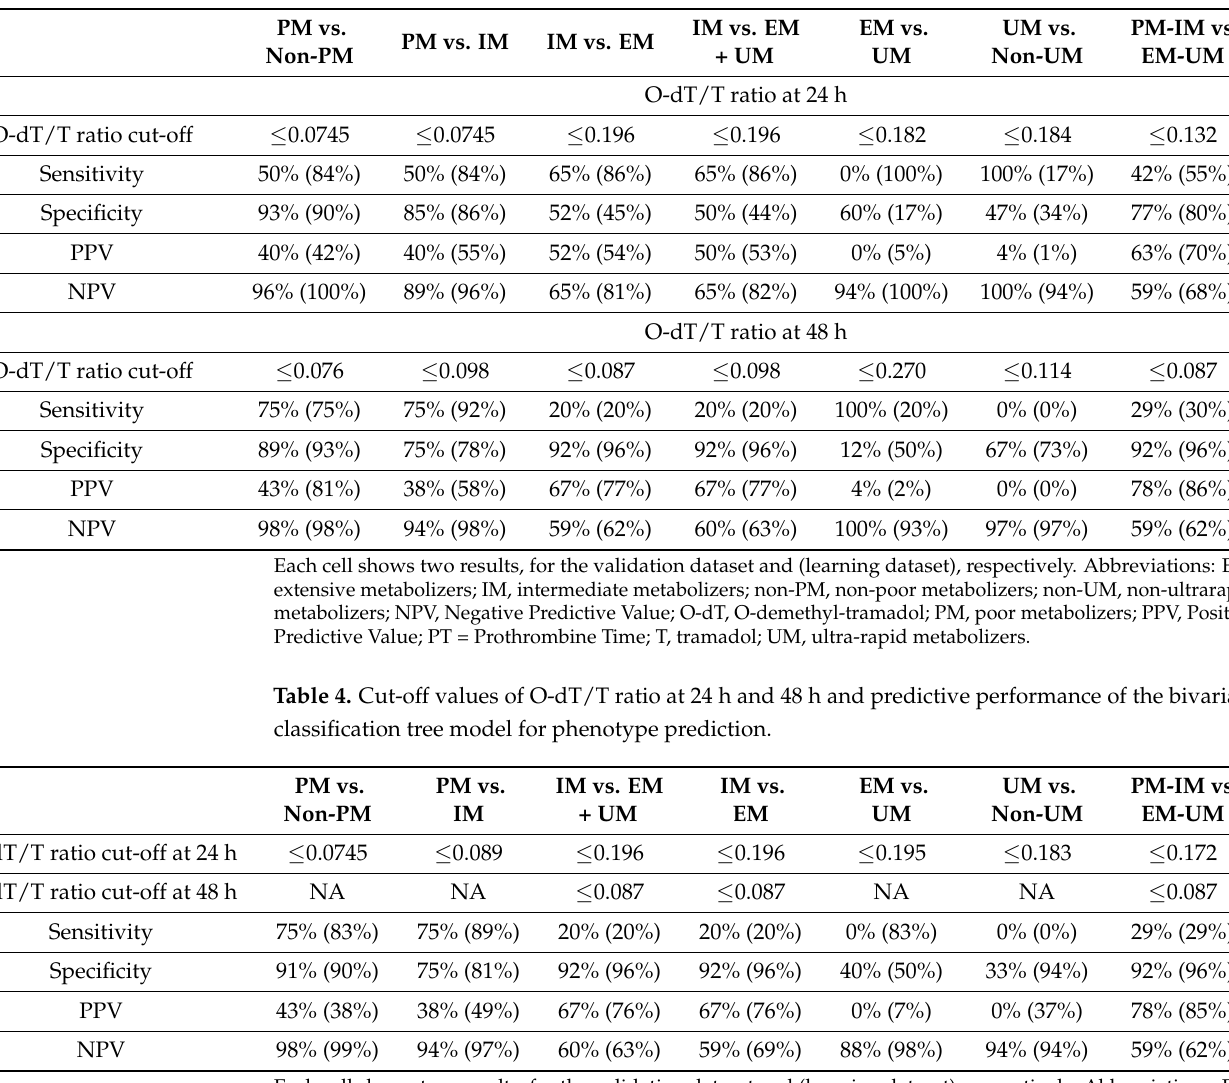
Table 3. Cut-off values of O-dT/T ratio at 24 h and 48 h and predictive performance of the univariate classification tree model for phenotype prediction.